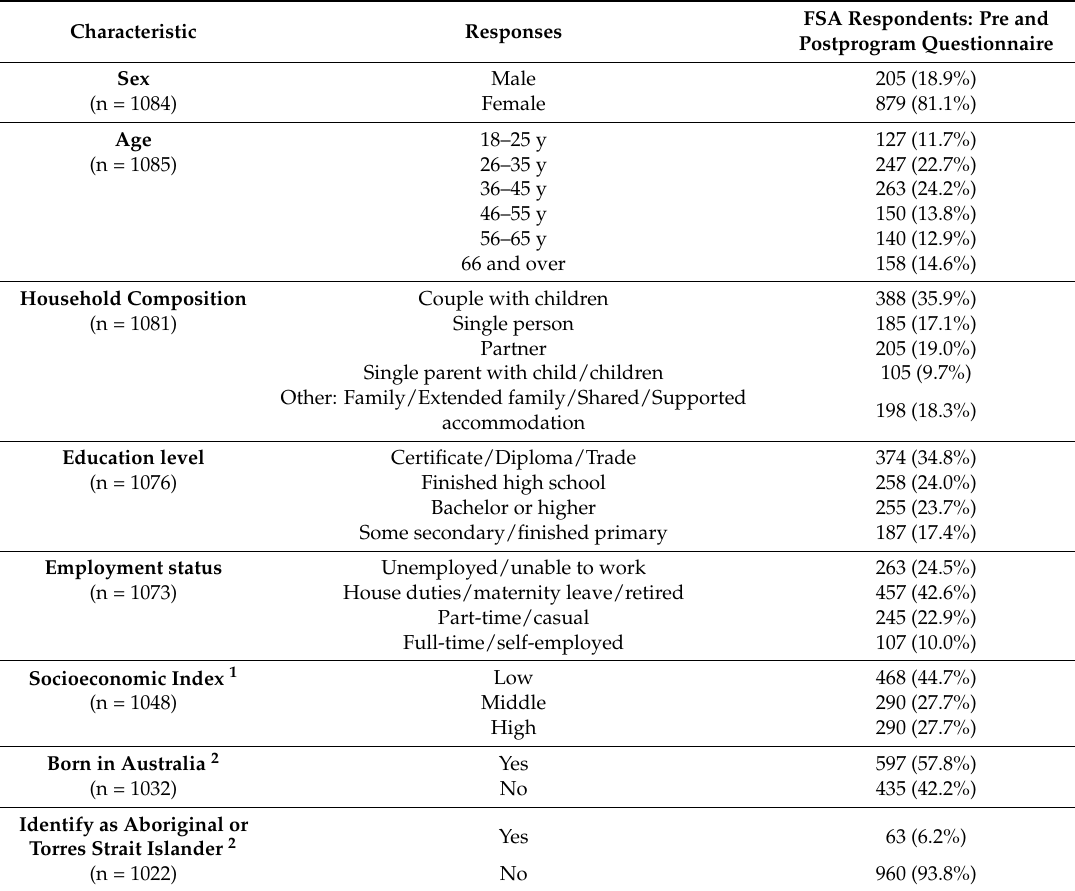
Table 1. Demographic characteristics of